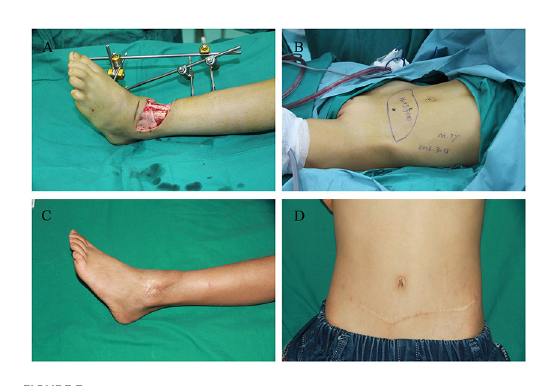
FIGURE3 Images of the 7-year-old boy in case 1. (A) Left ankle soft tissue defect caused by a car accident. (B) Transverse deep inferior epigastric perforator flap design. (C) Recipient site at 30 months postoperatively. (D) Donor site at 30 months postoperatively.